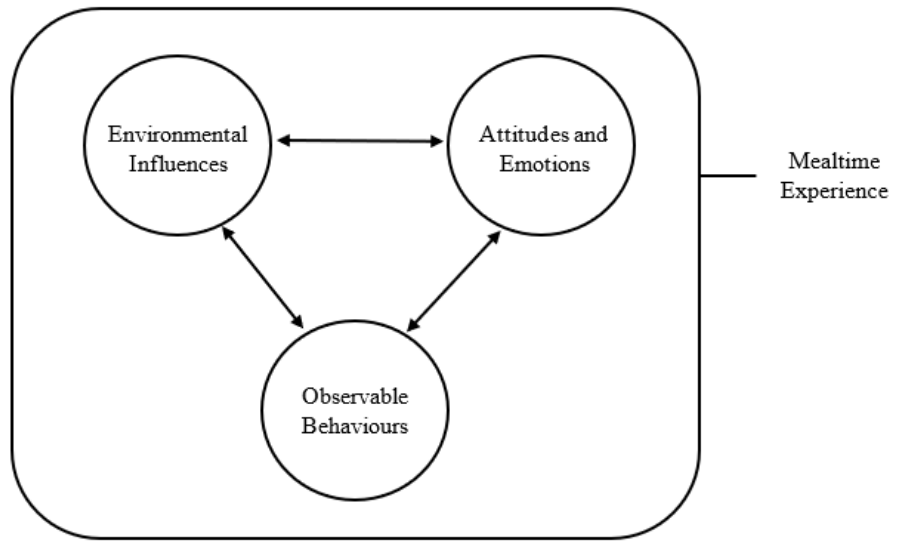
Figure 2. The multidirectional nature of mealtimes.